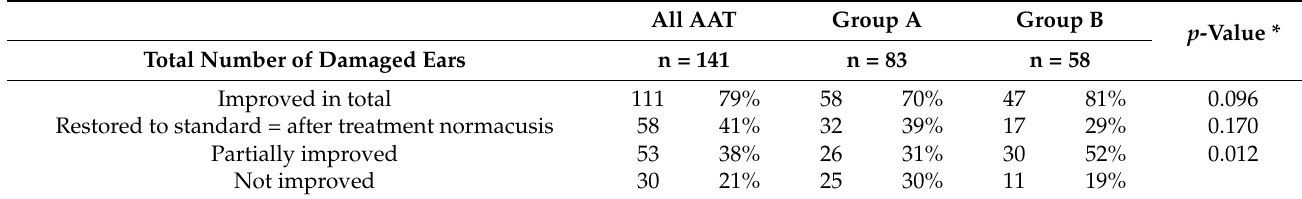
Table 1. Success of AAT treatment, All AAT, Group A (soldiers), Group B (civilians person). All AAT Group A Group B p -Value * Total Number of Damaged Ears n = 141 n = 83 n = 58 Improved in total 111 79% 0.096 Restored to standard = after treatment